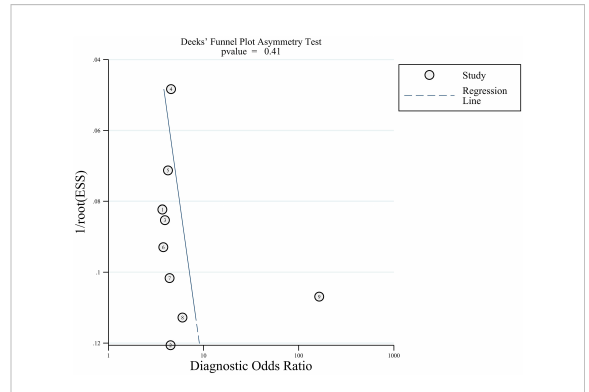
FIGURE 6 Deeks funnel plot of RNF180 gene methylation for GC